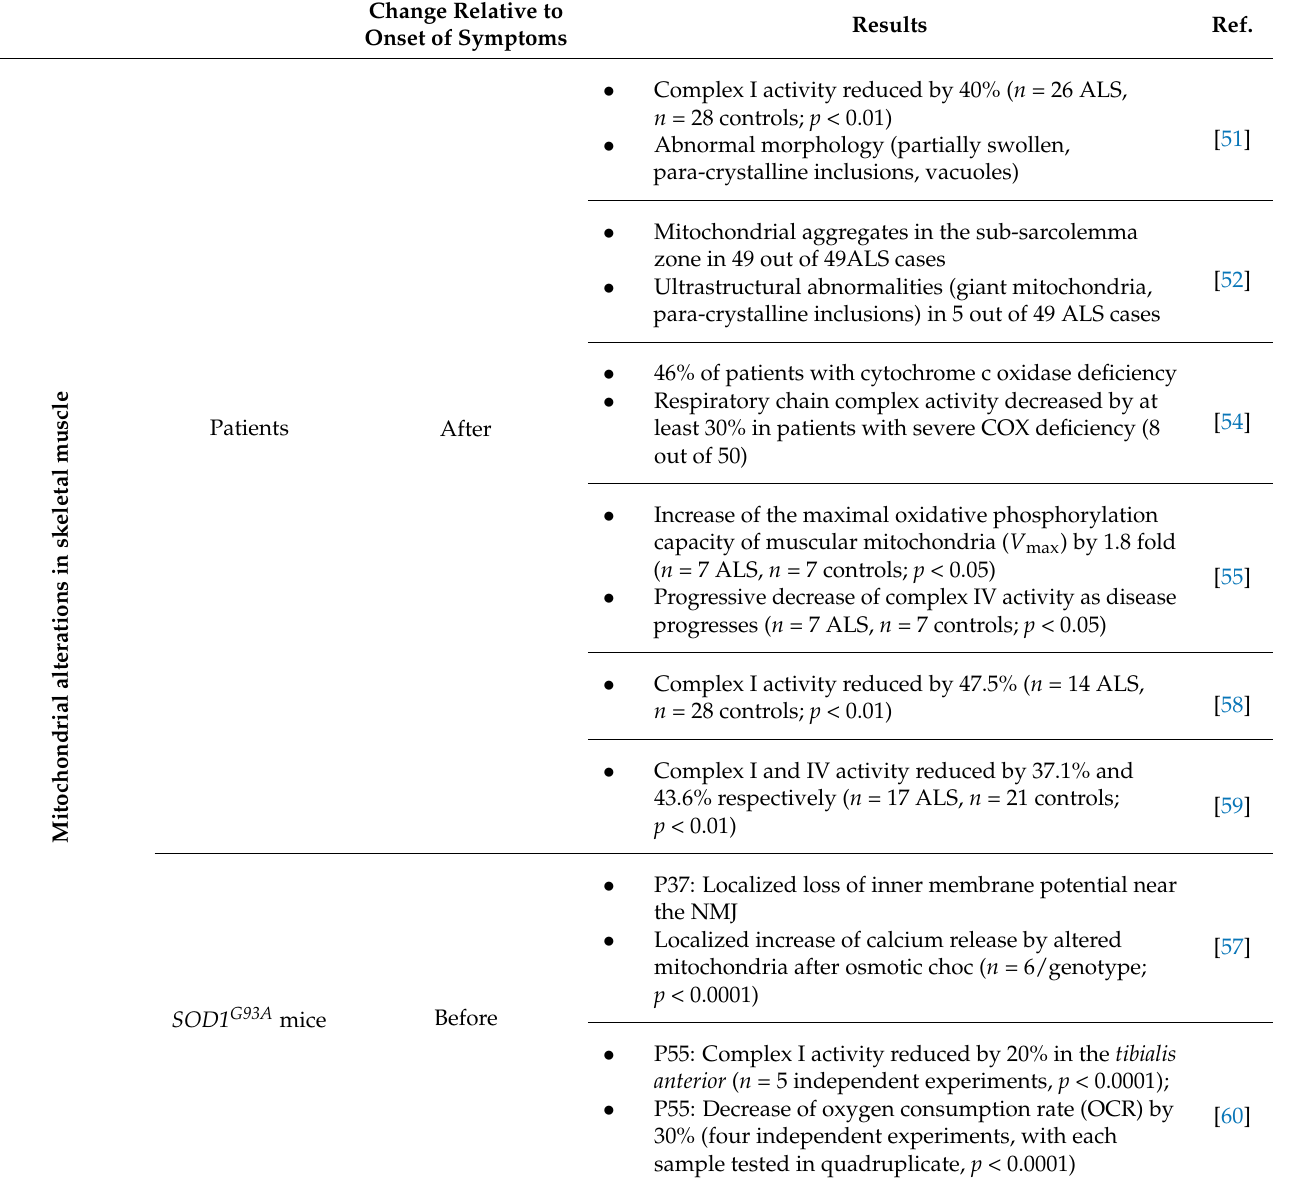
Table 2. Summary of the main mitochondrial changes found in skeletal muscle of ALS patients and ALS mouse models. Change Relative to Results Onset of Symptoms